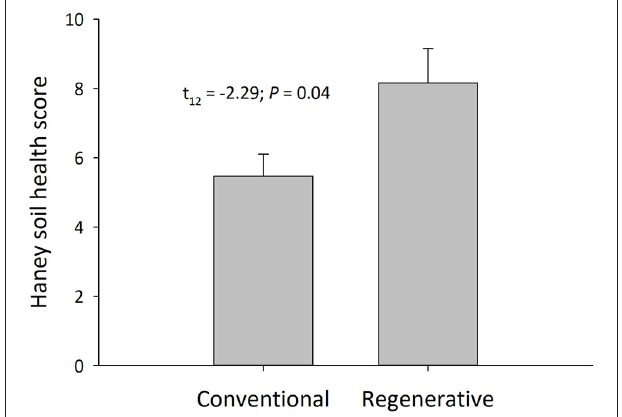
FIGURE 1 | Haney soil health scores in regenerative and conventional almond orchards (mean ± SEM, N = 16 orchards; Welch’s two-sample t -test; α =